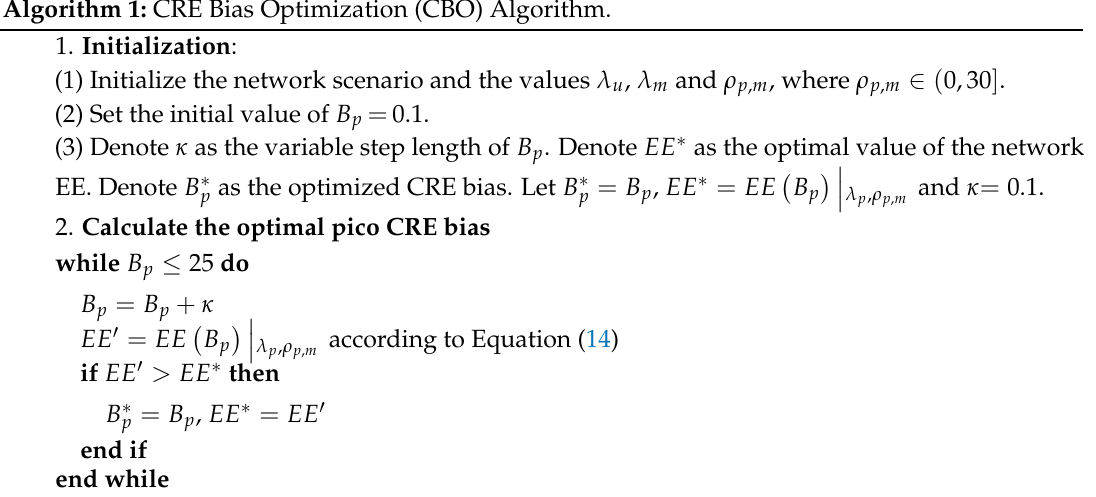
Algorithm 1: CRE Bias Optimization (CBO)